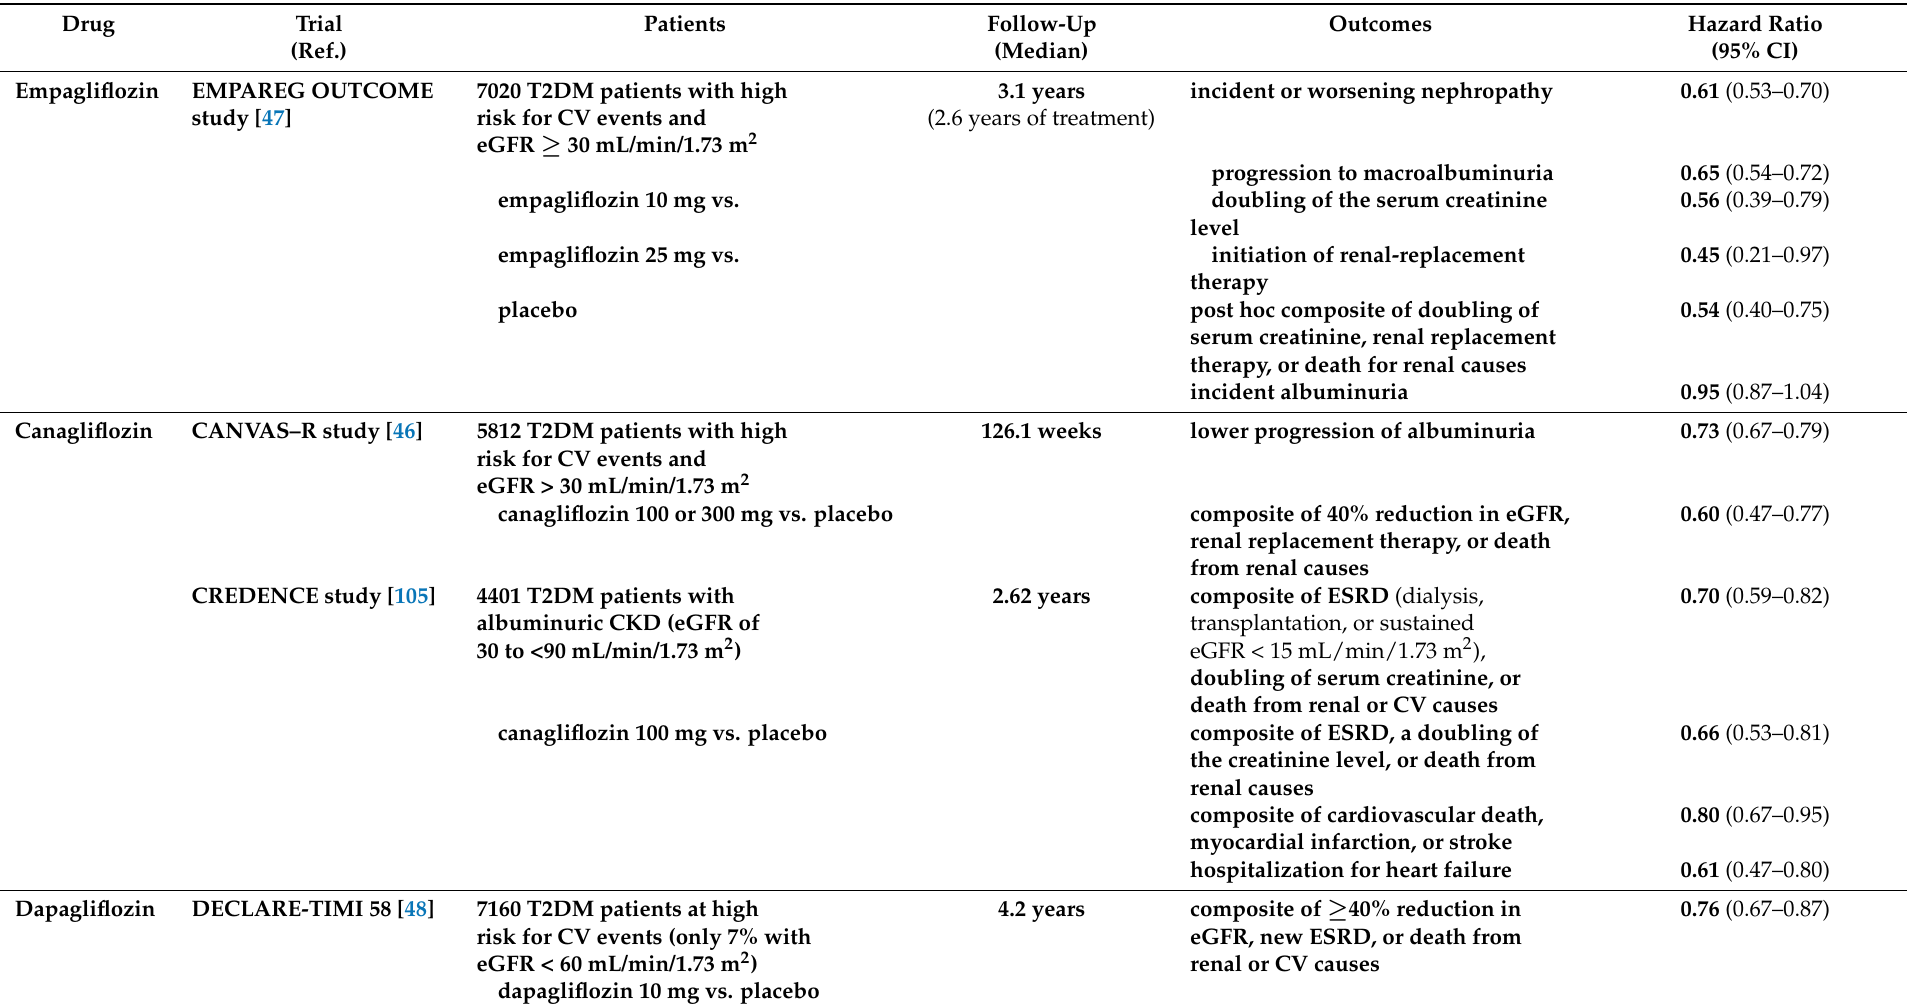
Table 2. Main clinical trials evaluating renal outcomes among patients treated with